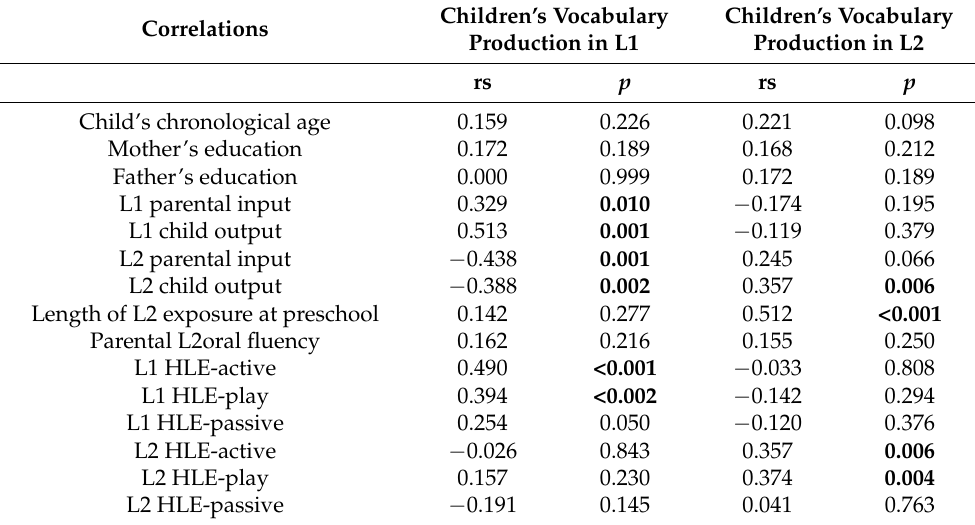
Table 2. Correlations between children’s vocabulary production in L1 and L2 demographics, quantity of language exposure measures, and quality of language exposure measures. Children’s Vocabulary Children’s Vocabulary Correlations Production in L1 Production in L2 Child’s chronological age